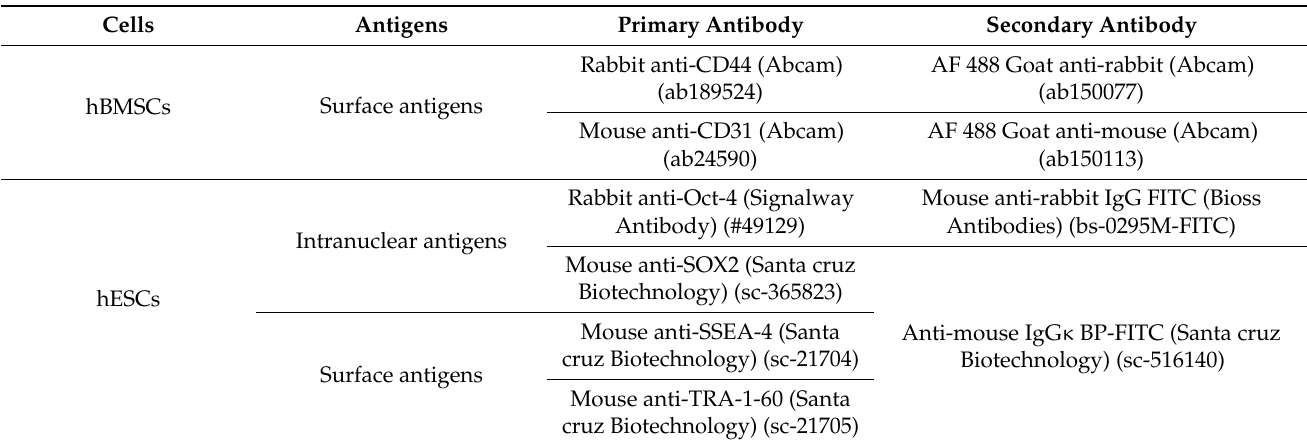
Table 2. Typical antibodies to confirm hBMSCs and hESCs.